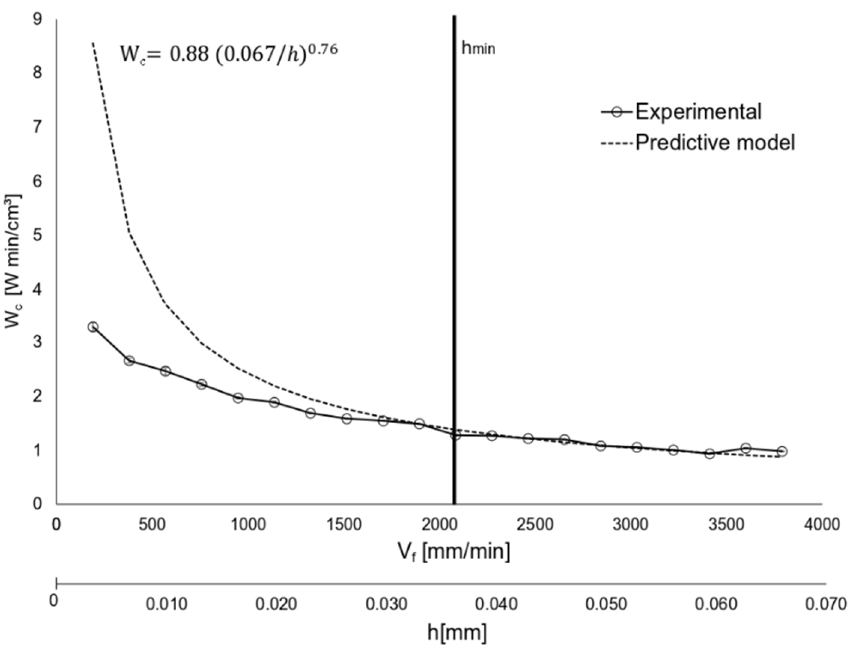
Figure 6 . Evolution of specific cutting energy in relation to feed rate/chip thickness with other parameters fixed (a spindle speed of 30,000 RPM, a radial depth of cut of 3 mm and an axial depth of cut of 0.7 mm) .